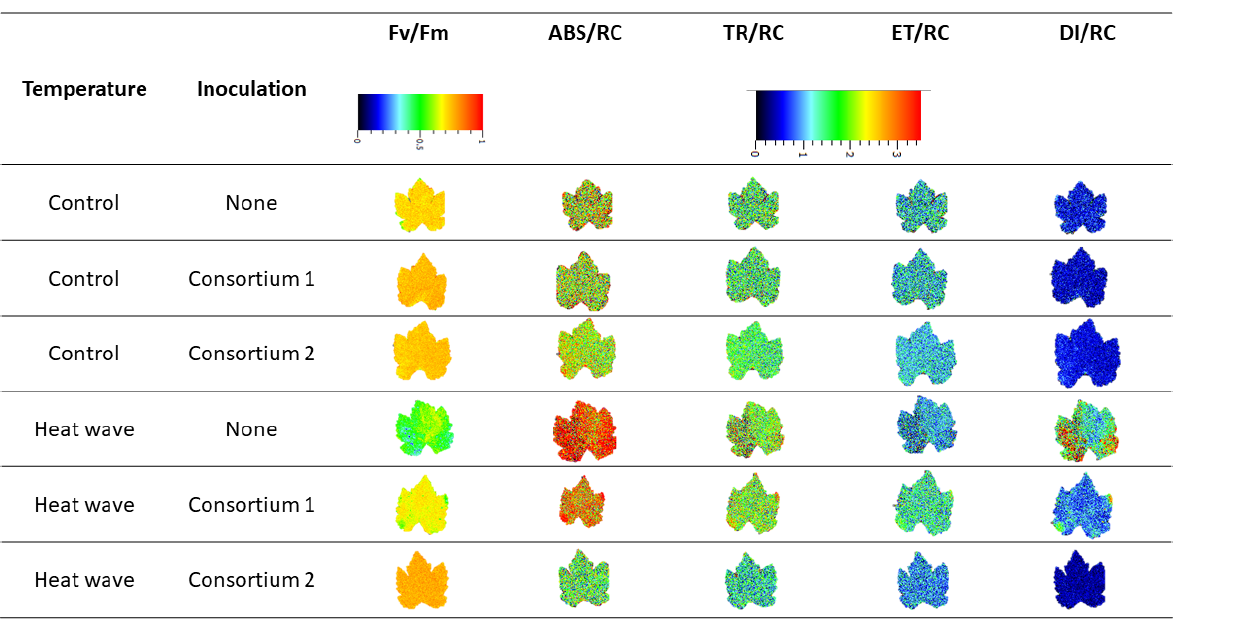
Figure 4. Imaging pulse amplitude modulated (iPAM) fluorescence derived parameter images: PS II quantum yield (F v /F m ), absorbed (ABS/RC), trapped (TR 0 /RC), transported (ET 0 /RC) and dissipated (DI 0 /RC) energy fluxes on a reaction centre basis relative to dark-adapted non-inoculated and marine PGPR consortia 1- and 2-inoculated Vitis vinifera leaves, under normal (control) thermal regimes and exposed to the heatwave .